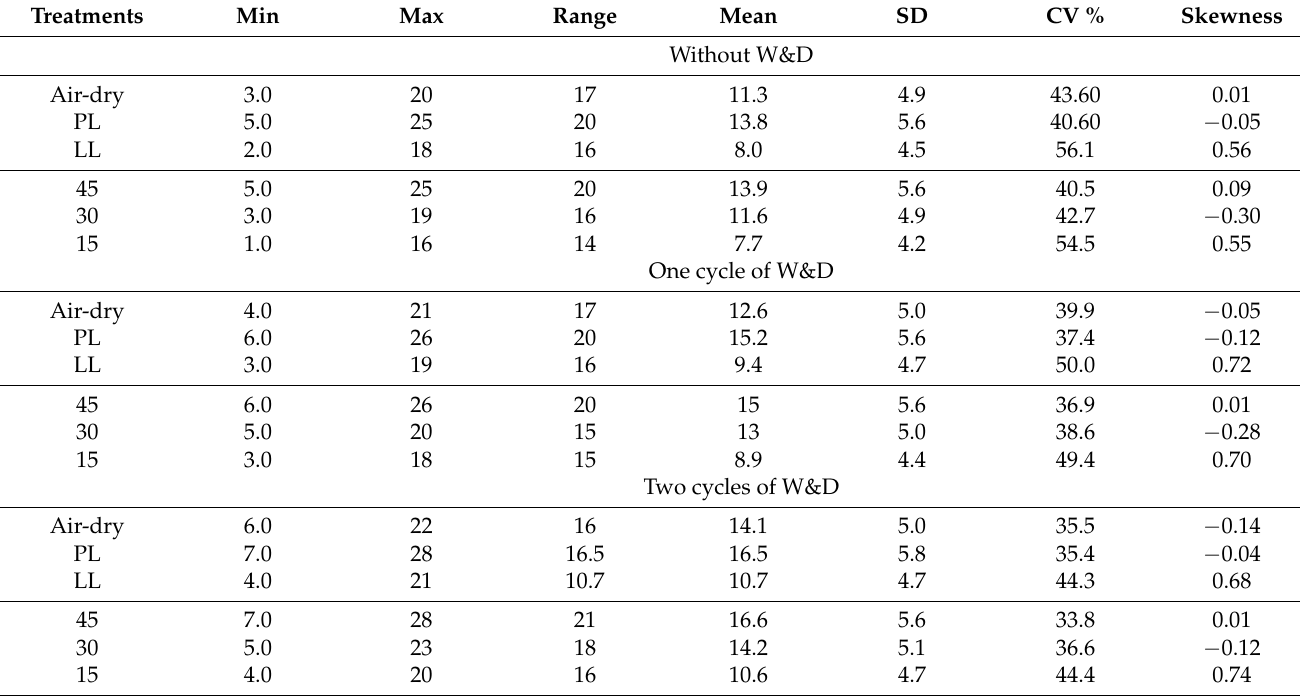
Table 3. Summary of statistics of cohesion (kPa) for the studied clay–sand mixtures and clay soil at different water contents and clay contents (kg 100 kg − 1 ) in various wetting and drying (W&D) cycles ( N =